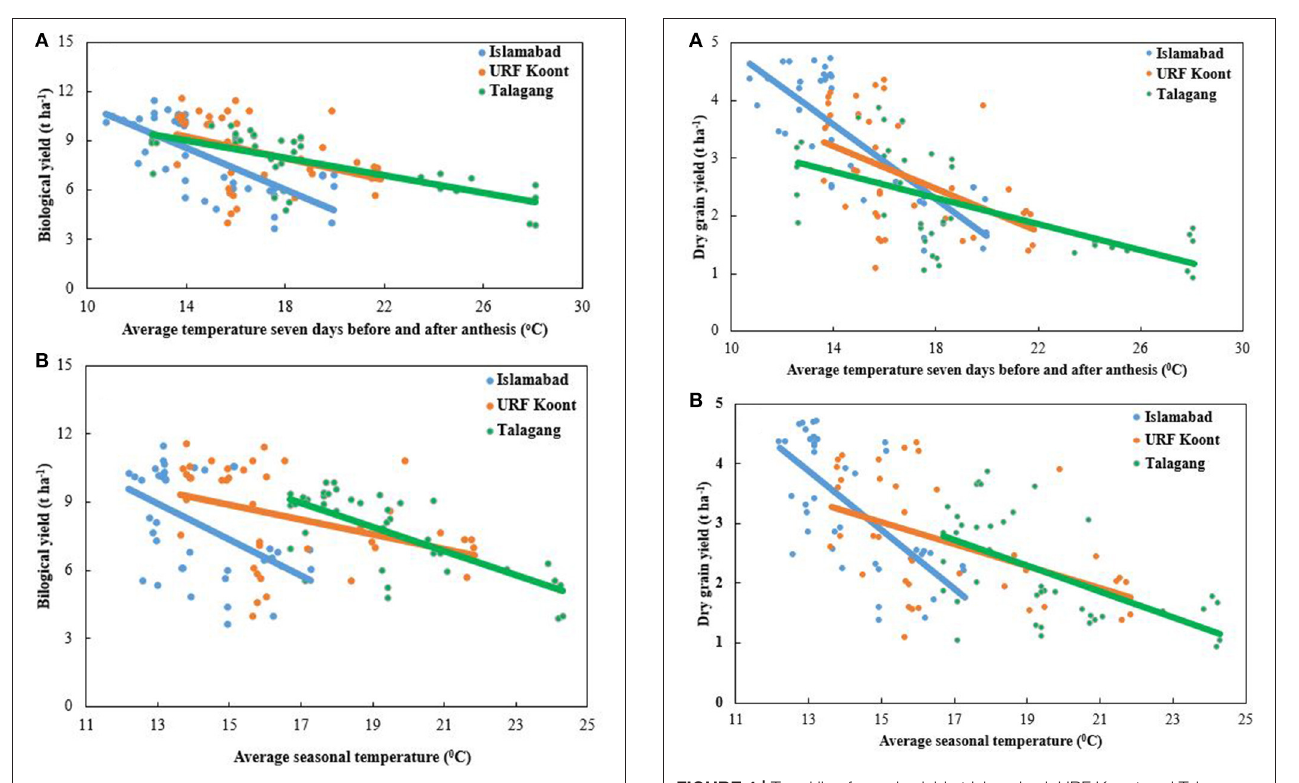
FIGURE 3 | Trend line for biological yield at Islamabad, URF Koont and Talagang including four sowing dates and 2 years as a function of (A) average temperature 7 days before and after anthesis, and (B) average seasonal temperature.